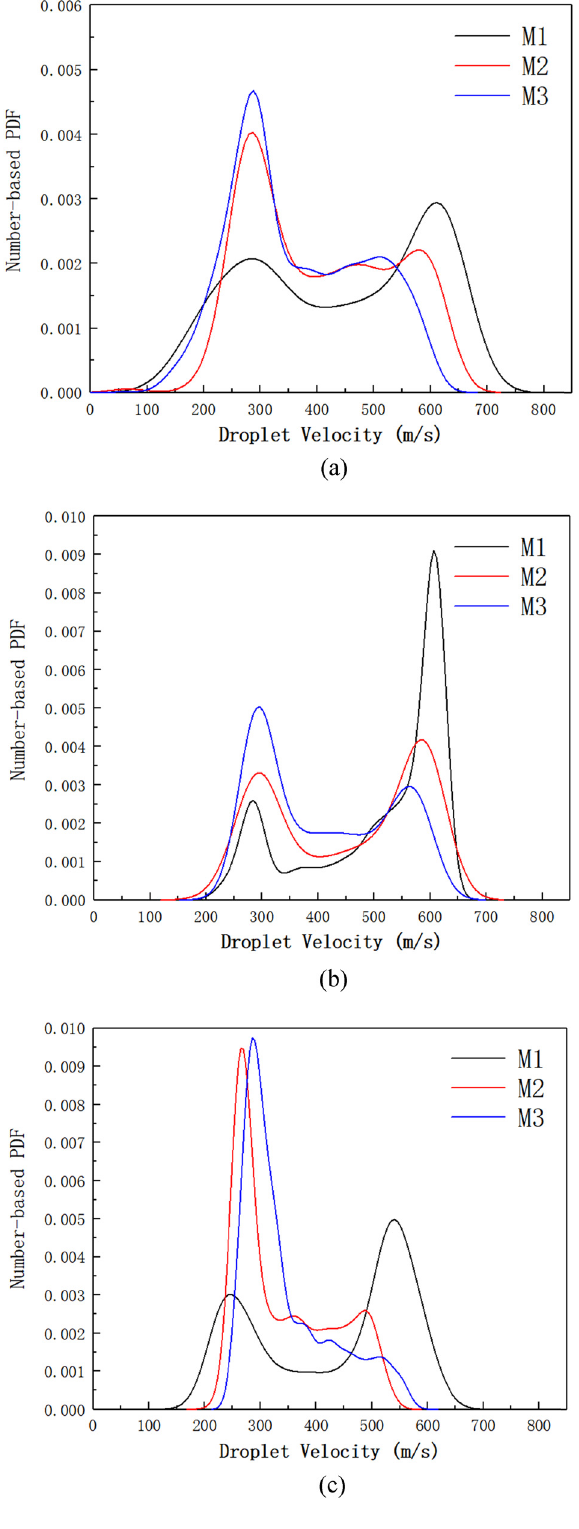
Figure 15: Droplet velocity distribution at di ff erent locations down - stream of the nozzles. The droplet velocity distribution of the ( a ) 0A nozzle, ( b ) 30V nozzle, and ( c ) 30Y